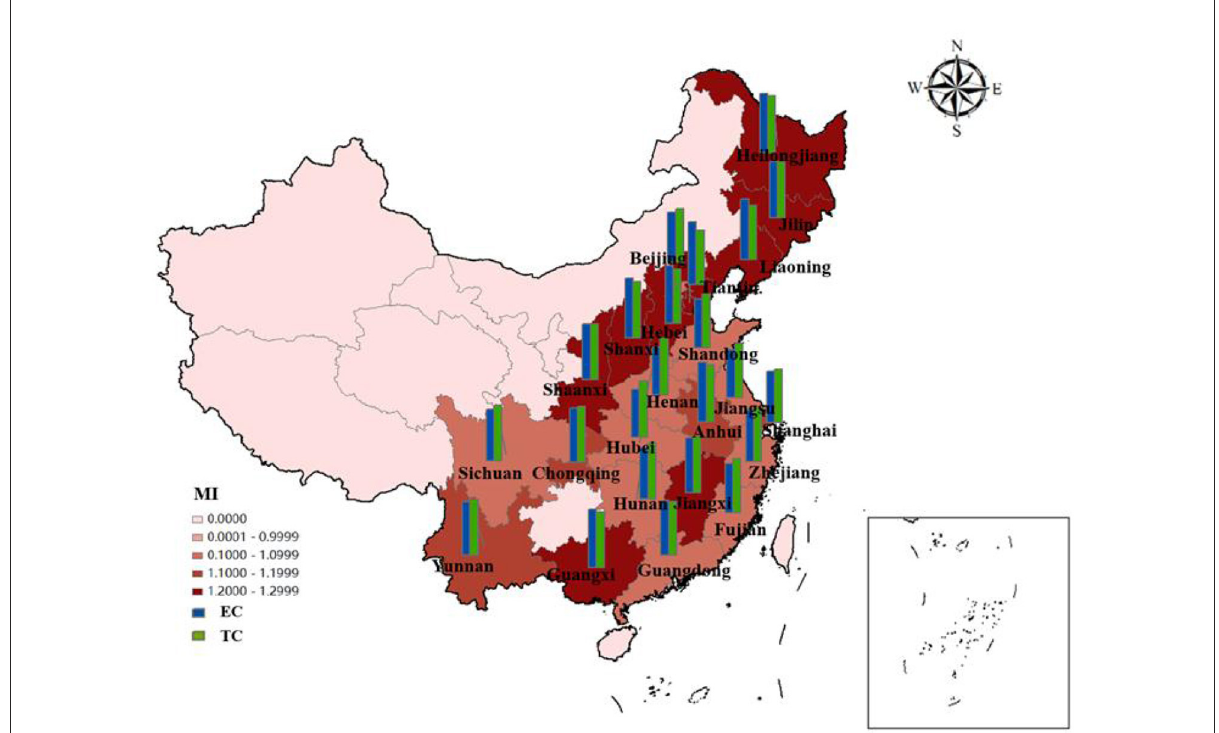
FIGURE8 Average efficiency and its decomposition index of EETS in 23 Chinese provinces from 2010 to 2020.